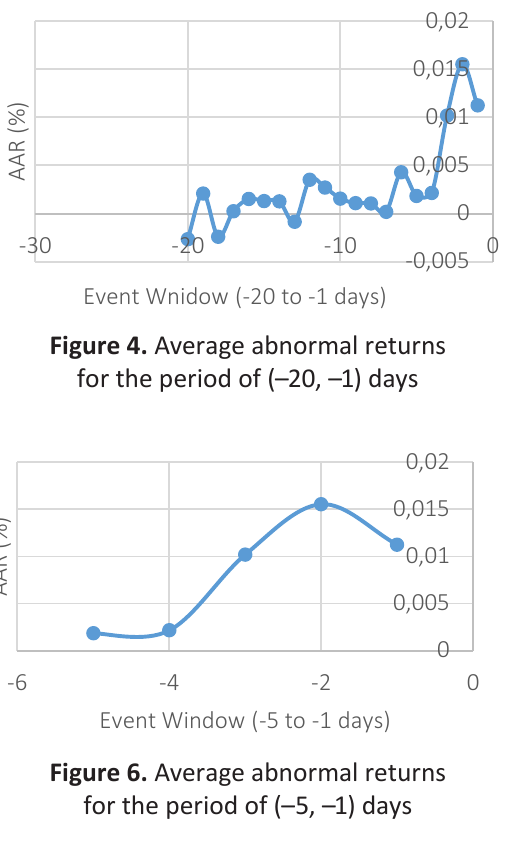
Figures 4 to 11 indicate the varying price reaction due to buyback